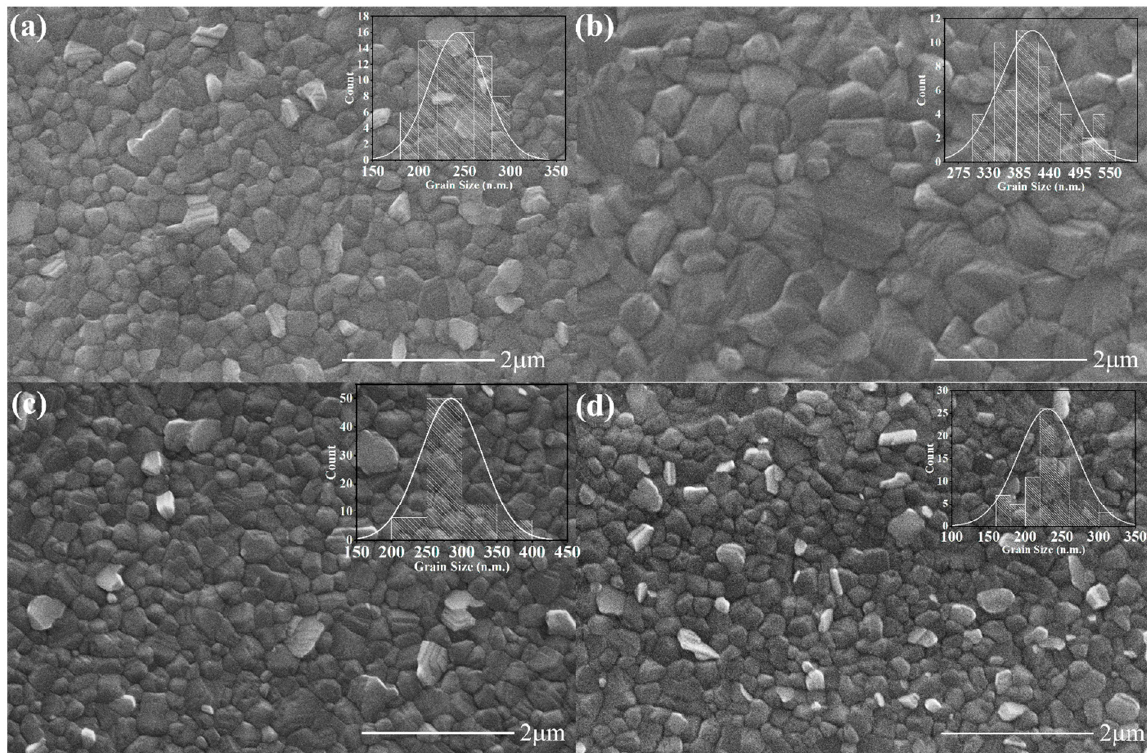
Figure 3. SEM images of perovskite films deposited over PEDOT:PSS with Ti 3 C 2 T x doping concen- trations of ( a ) 0 wt.%, ( b ) 0.03 wt.%, ( c ) 0.05 wt.%, and ( d ) 0.1 wt.% (the insets show crystal size measurements of perovskite using ImageJ software).